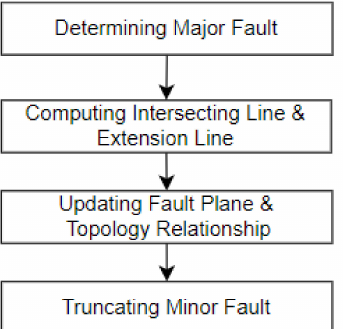
Figure 5. Automatic calculation process of fault contact